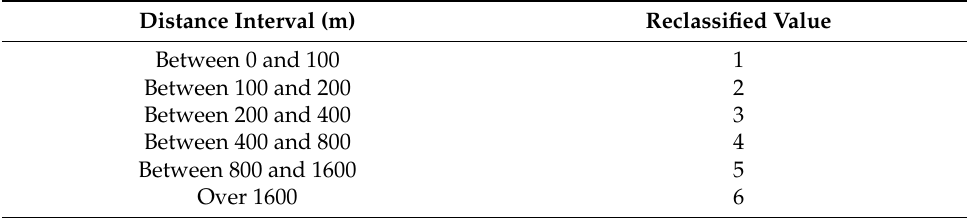
Table 1. Classification of distance to artificialized territories.